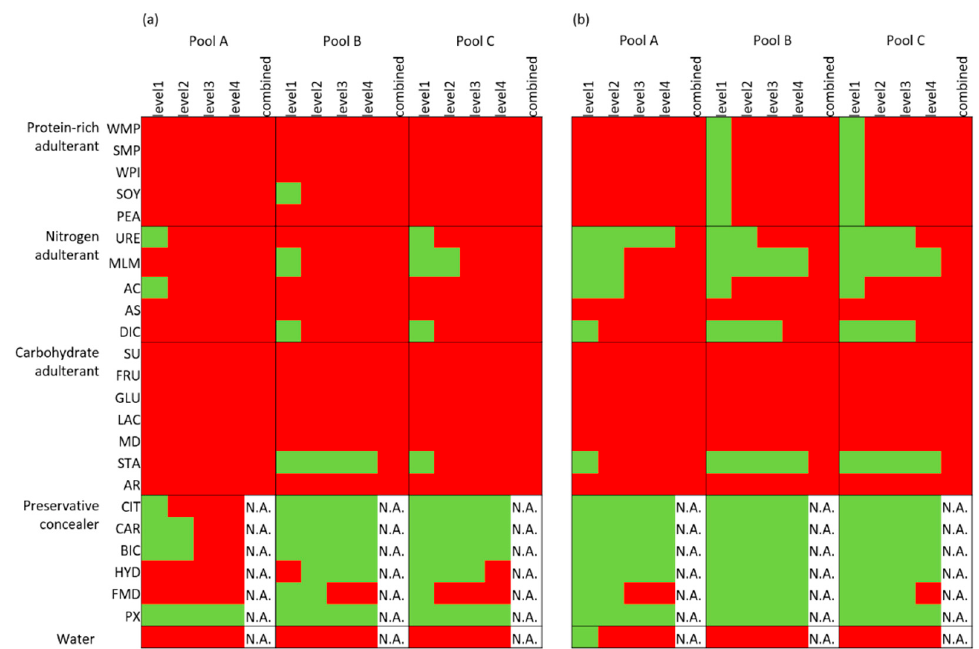
Figure 2. The results of the adulterant test sets for the three milk pools based on ( a ) the measured boundaries of the univariate detection and ( b ) the variance-adjusted boundaries of the univariate detection, indicating the potential to identify suspected milk adulterations. The samples with all results within the boundaries are coloured green, while the rest is coloured red. The full names of the adulterants are shown in the abbreviations list. For interpretation of the different colours, refer to the web version of the paper. N.A., not applicable.